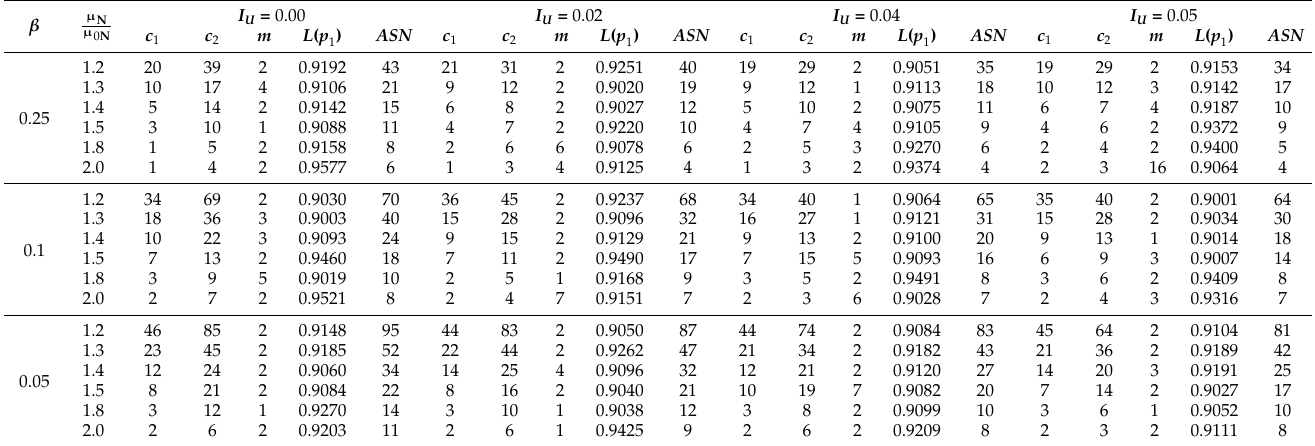
Table 10. The MDS design values for α = 0.10, ν = 3.1946, and a =